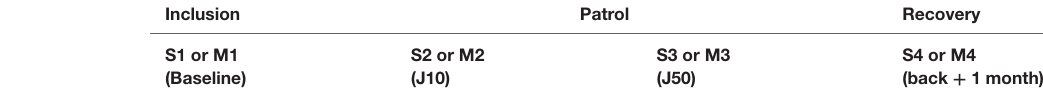
Inclusion Patrol